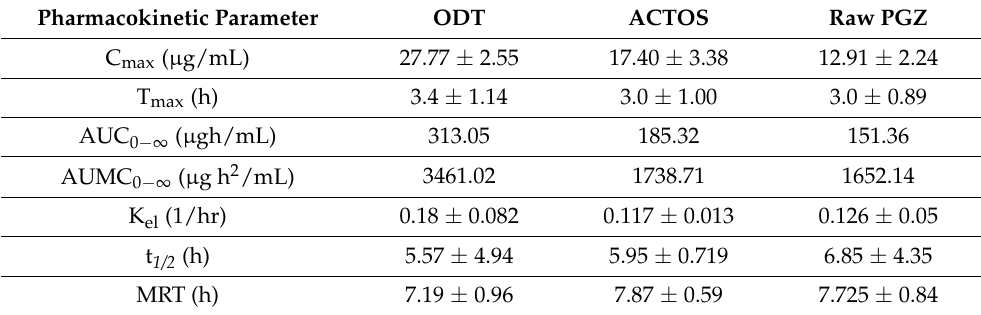
Figure 9. In vitro dissolution profile of: ( a ) PGZ from the optimized ODT batch, S-SNEDDS, L- SNEDDS, commercial tablet and raw PGZ, ODT versus marketed tablet ( b ) and ODT versus raw drug ( c ). Abbreviations: L-SNEDDS, liquid self-nanoemulsifying drug delivery system; S-SNEDDS, solidified self-nanoemulsifying drug delivery system; ODT, oral disintegrating tablet; PGZ, Pioglita- zone Hydrochloride. Table 9. The plasma pharmacokinetic parameters of the ODT tablet, commercial tablet and raw PGZ after a single dose oral administration to Wistar rats (mean ± SD, n =